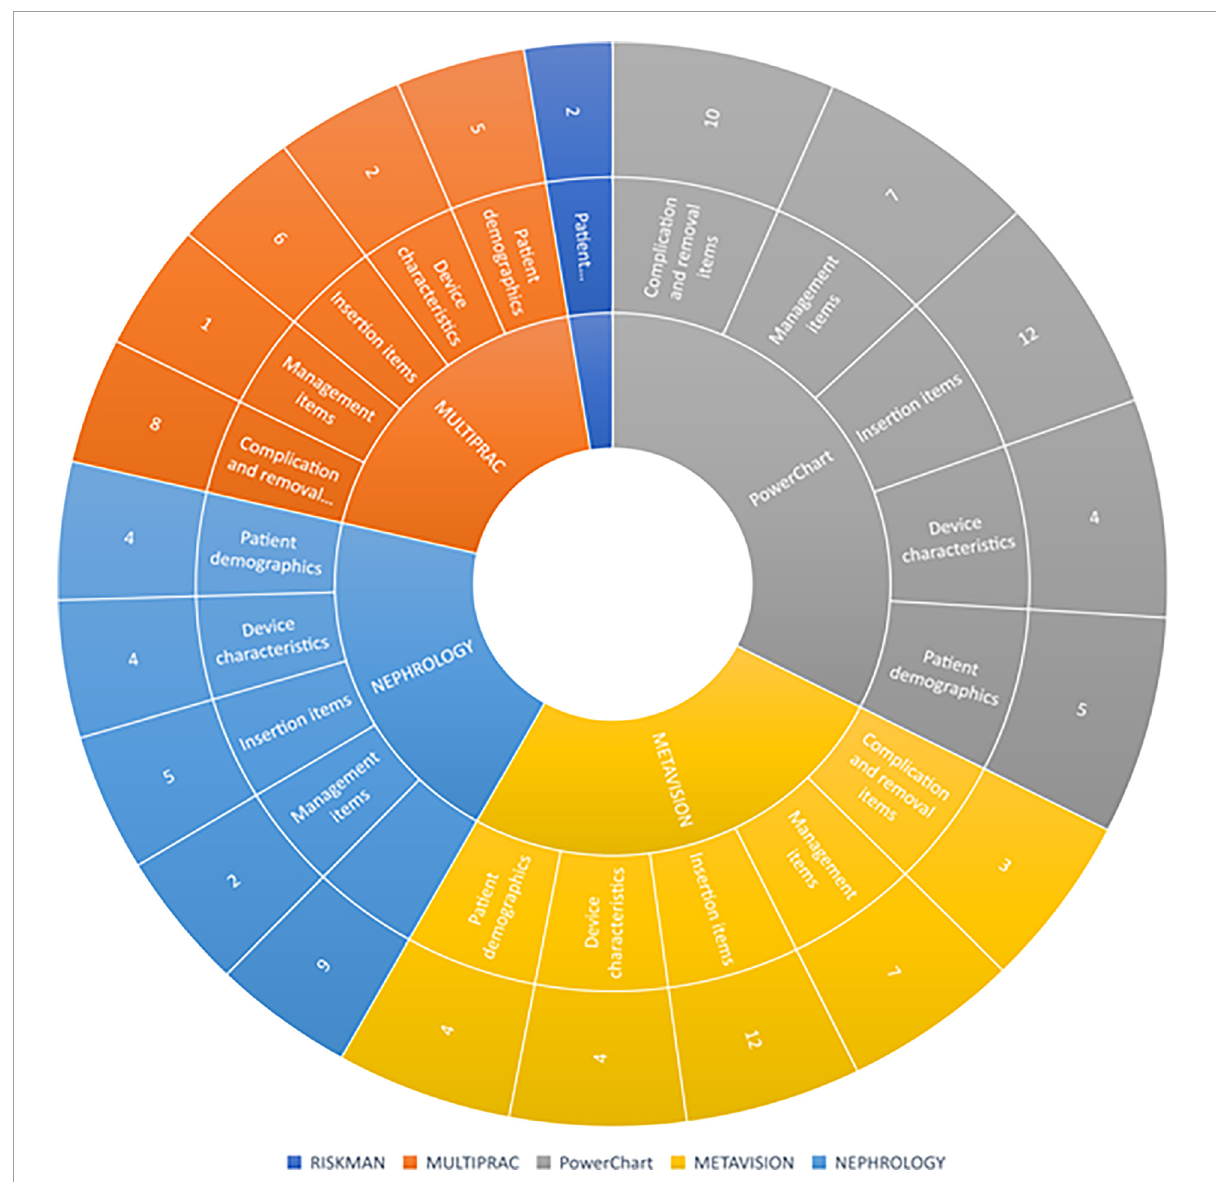
FIGURE3 Sunburst diagram of vascular access items collected in Queensland Health electronic platforms. Each concentric circle represents a level of navigation from the top of the tree. In the majority of platforms, data items are displayed separately on different “pages” or “screens” from other items, requiring the user to view multiple screens to get a comprehensive clinical overview of vascular access items